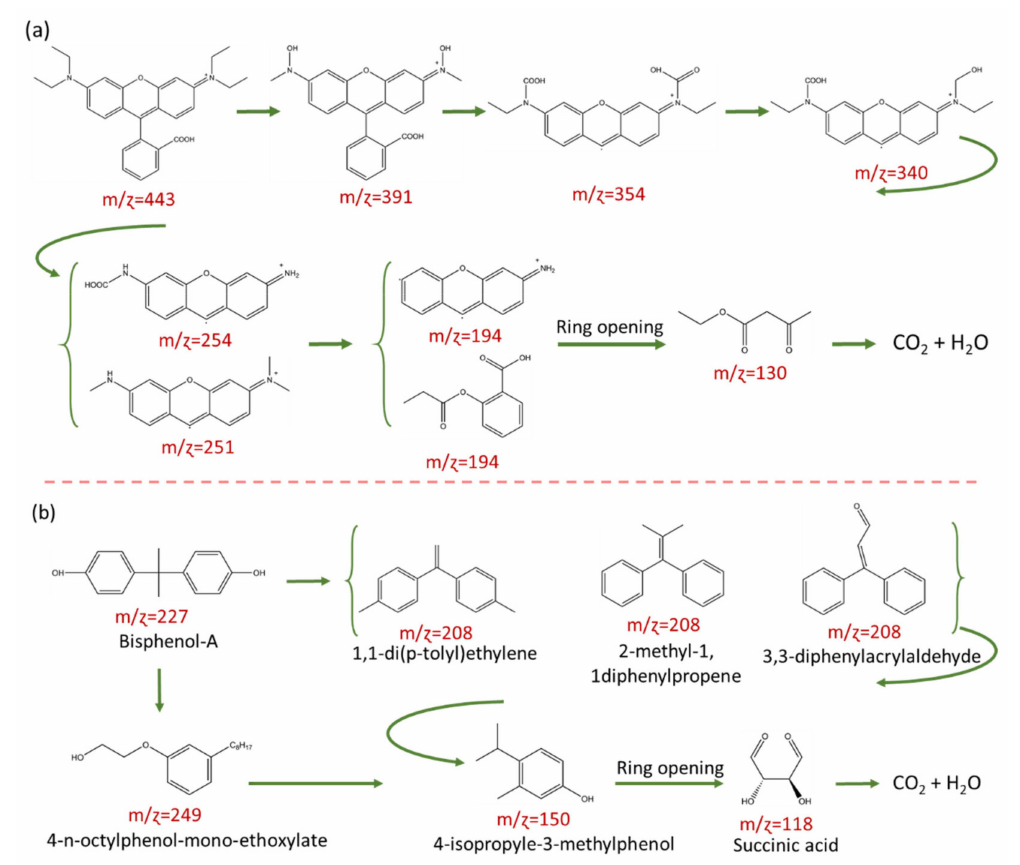
Figure 7. Photocatalytic degradation pathway and possible reaction intermediates in ( a ) RhB and ( b ) BPA over BOC/BOI-3.